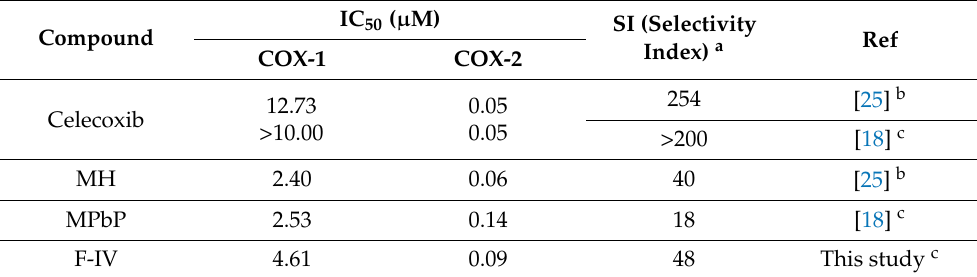
Table 1. In vitro COX-1 and COX-2 inhibition data.